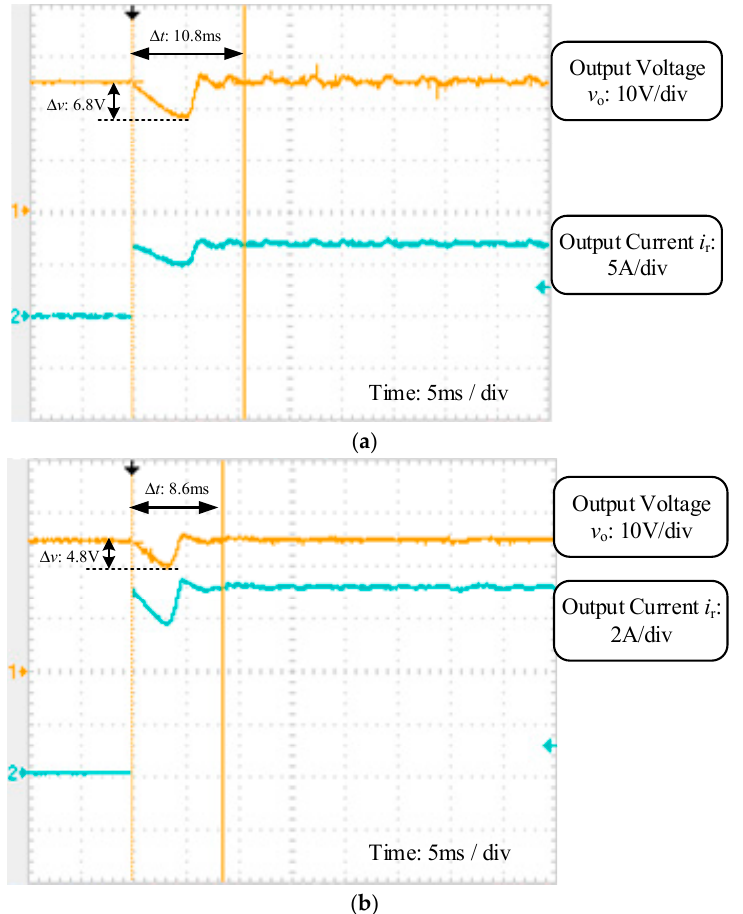
Figure 8. Experimental waveforms of output voltage and current for ( a ) a single-loop controller and ( b ) a double-loop controller.